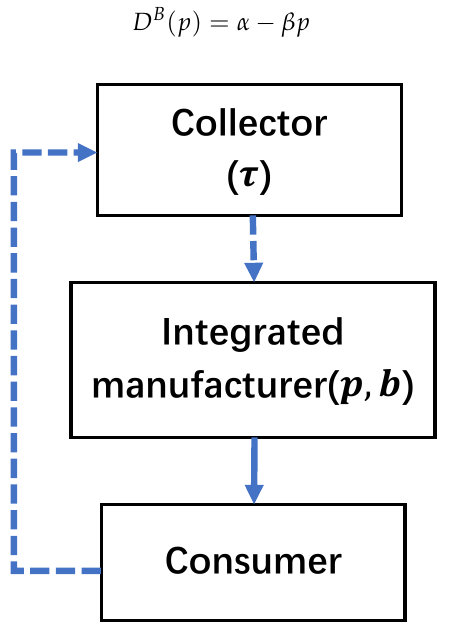
Figure 1. The closed-loop supply chain (CLSC) structure of model B